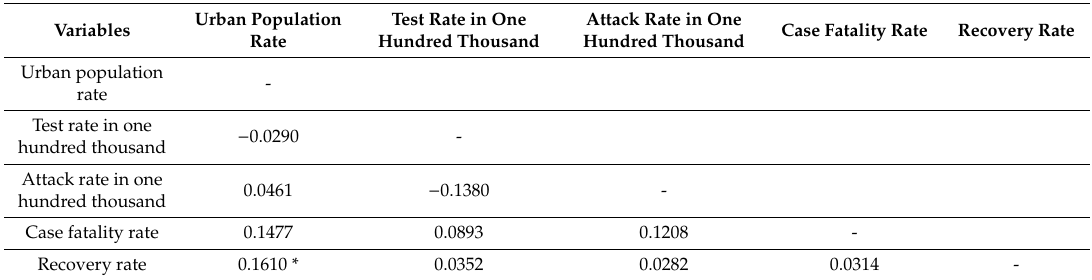
Figure 2. Correlation between median age and recovery rate. Table 3. Correlation analysis between urban population rate and COVID-19 test, attack, fatality, and recovery